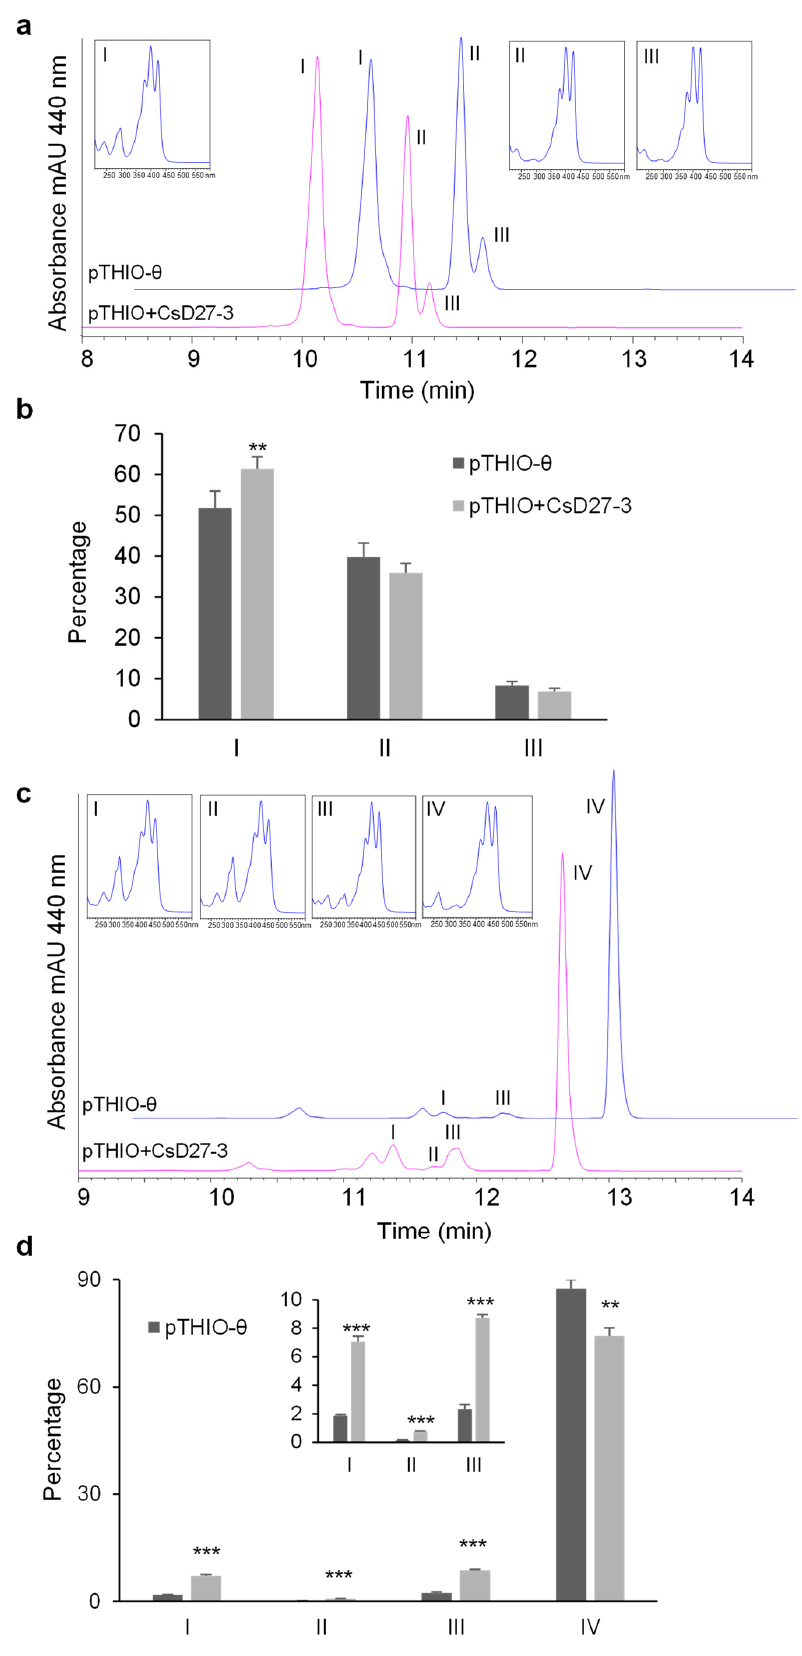
Figure 7. Analysis of CsD27-3 activity in E. coli cells accumulating the linear carotenoids ζ -carotene and neurosporene. ( a ) HPLC analyses of carotenes extracted in the absence (pThio- θ ) and